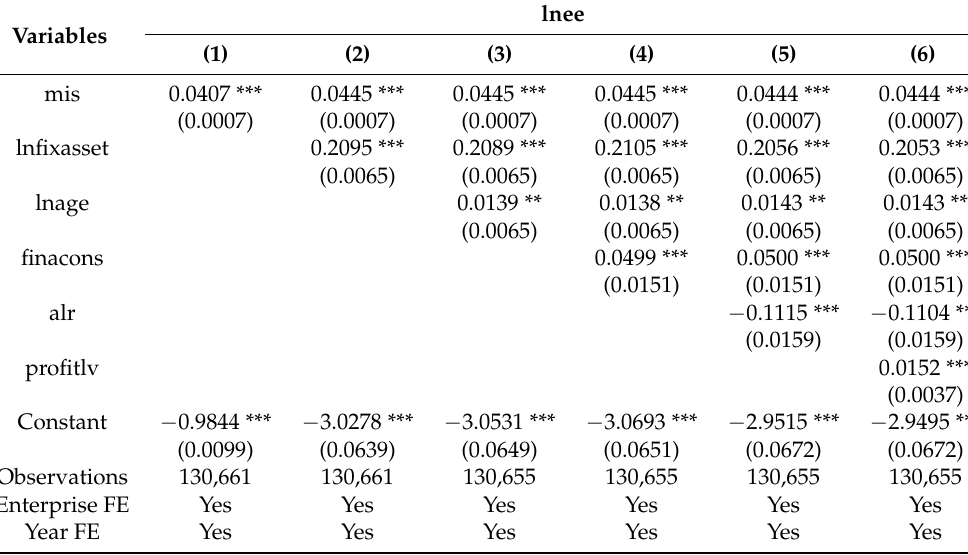
Table 6. Empirical results of Hypothesis